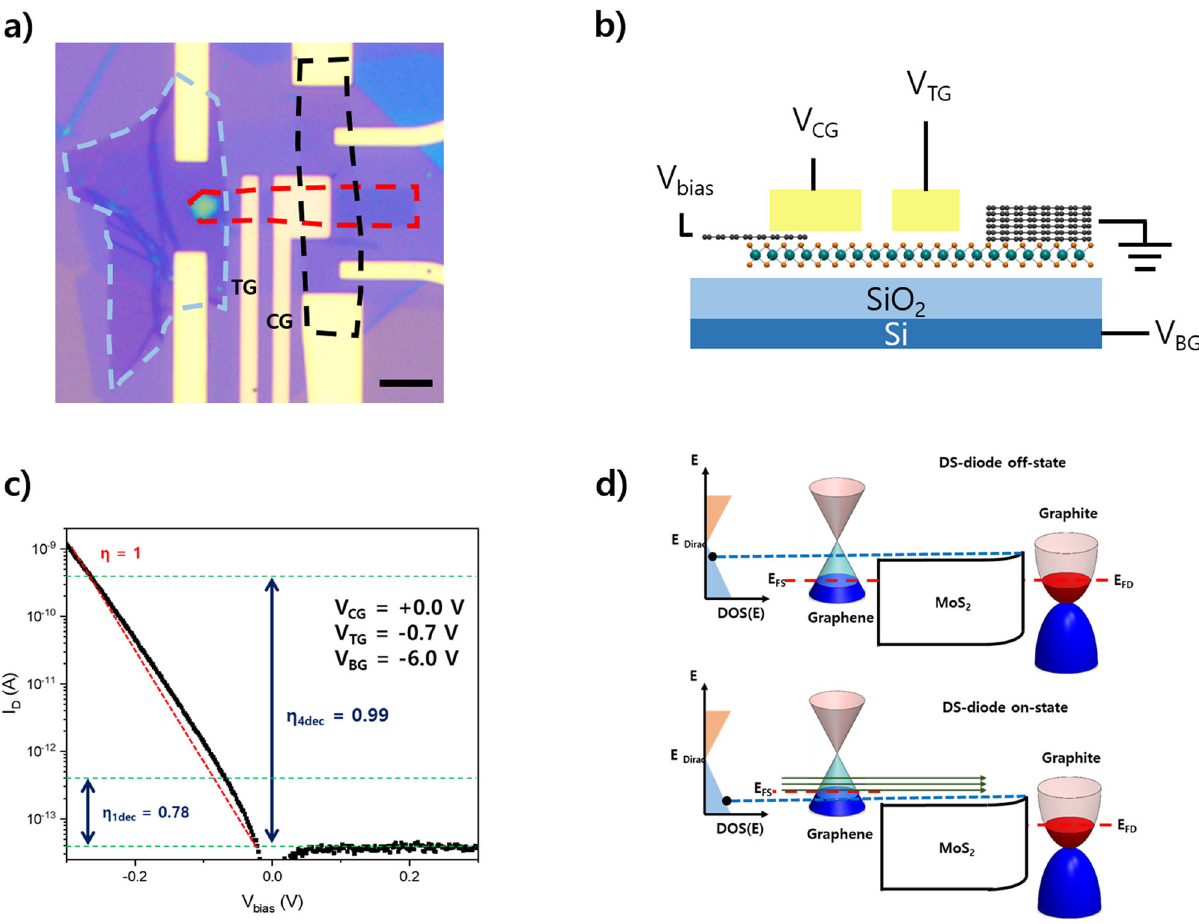
Fig. 1 Device structure, characteristic curve, and band diagram of DS diode. a Optical image of graphene/MoS 2 /graphite heterojunction diode. Grey, red, and black dashed lines indicate graphite, monolayer MoS 2 , and graphene, respectively. We used graphene as a source and graphite as a drain. The top- gate(TG) and control-gate(CG) were placed for gate modulation of the MoS 2 channel and graphene/MoS 2 overlapped region, respectively. Scale bar, 5 um. b Schematic image of graphene/MoS 2 /graphite heterojunction diode. c Characteristic drain current( I D )-bias voltage( V bias ) curve in our device, which exhibits ideality factor( η ) = 0.78 in 1 decade of current and an average η < 1 in more than four decades of current, i.e., η ave_4dec < 1. The rectifying ratio of our device is larger than 10 8 . d Band diagram of DS Schottky diode, which explains the working principle of cold electron injection from graphene. E Dirac , DOS, E FS , and E FD indicate Energy at the Dirac point, the density of states, Fermi level at the source side, and Fermi level at the drain side, respectively. Blue dashed line and green arrows indicate MoS 2 energy window level and expression of rapid increment of current fl